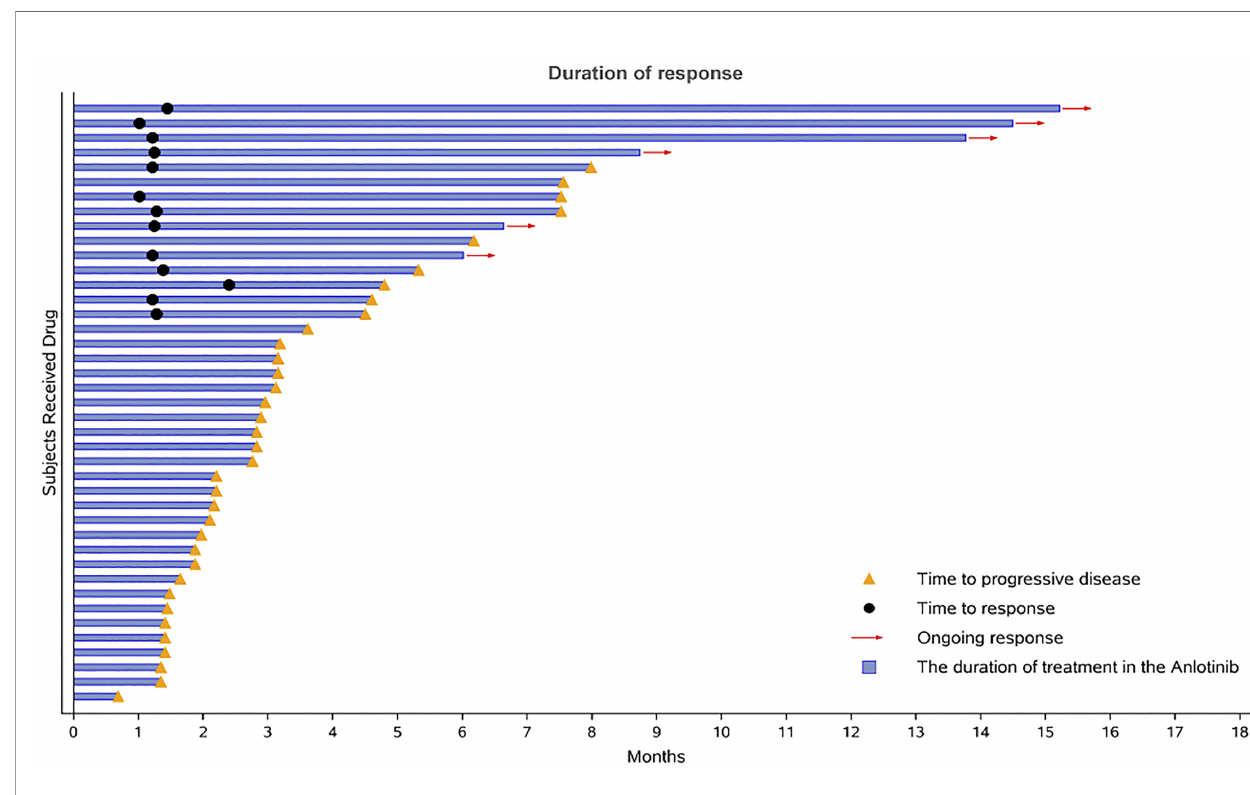
FIGURE 2 | Duration of responses. The length of each bar represents the duration of treatment for each